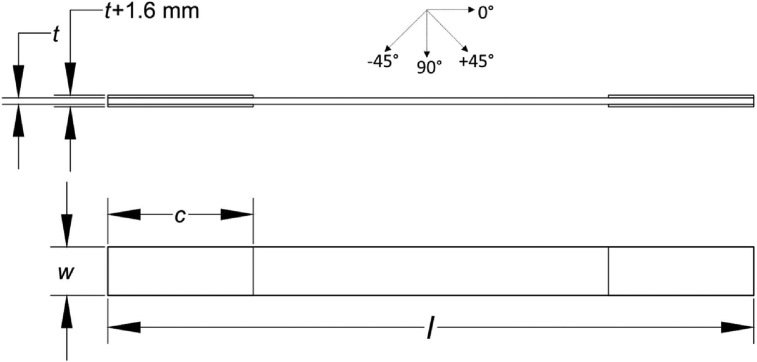
Specimen dimension [2].